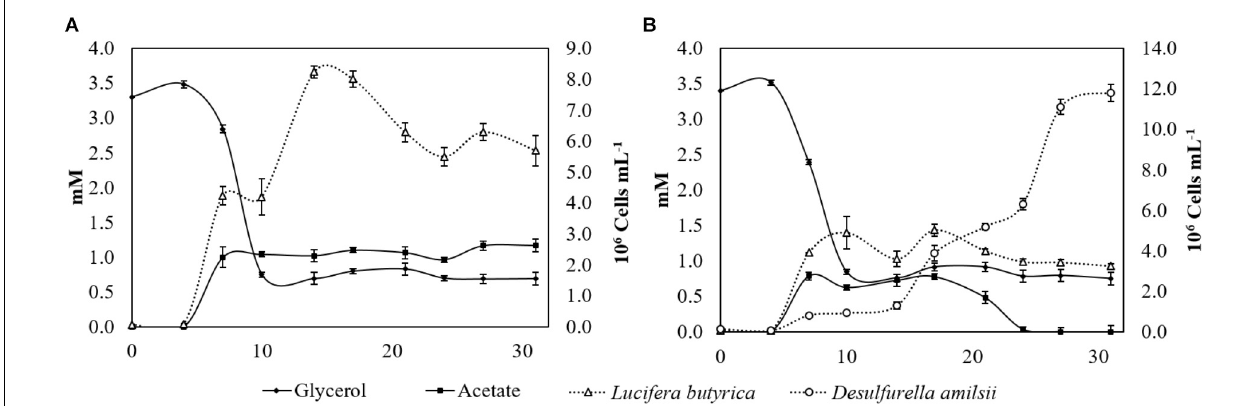
FIGURE 4 | (A) Glycerol consumption, acetate production and number of cells of strain ALE T growing in a pH-controlled batch reactor with glycerol and sulfur. 1,3-PDO (1.07 mM), ethanol (0.72 mM), butyrate (0.26 mM), and propionate (0.42 mM) production was not displayed in the graph for clarity purposes. (B) Glycerol, acetate and number of cells profile of strain ALE T growing in co-culture with D. amilsii in a pH-controlled batch reactor with glycerol and sulfur. 1,3-PDO (1.33 mM), ethanol (0.19 mM), butyrate (0.15 mM), and propionate (0.35 mM) production was not displayed in the graph for clarity purposes.